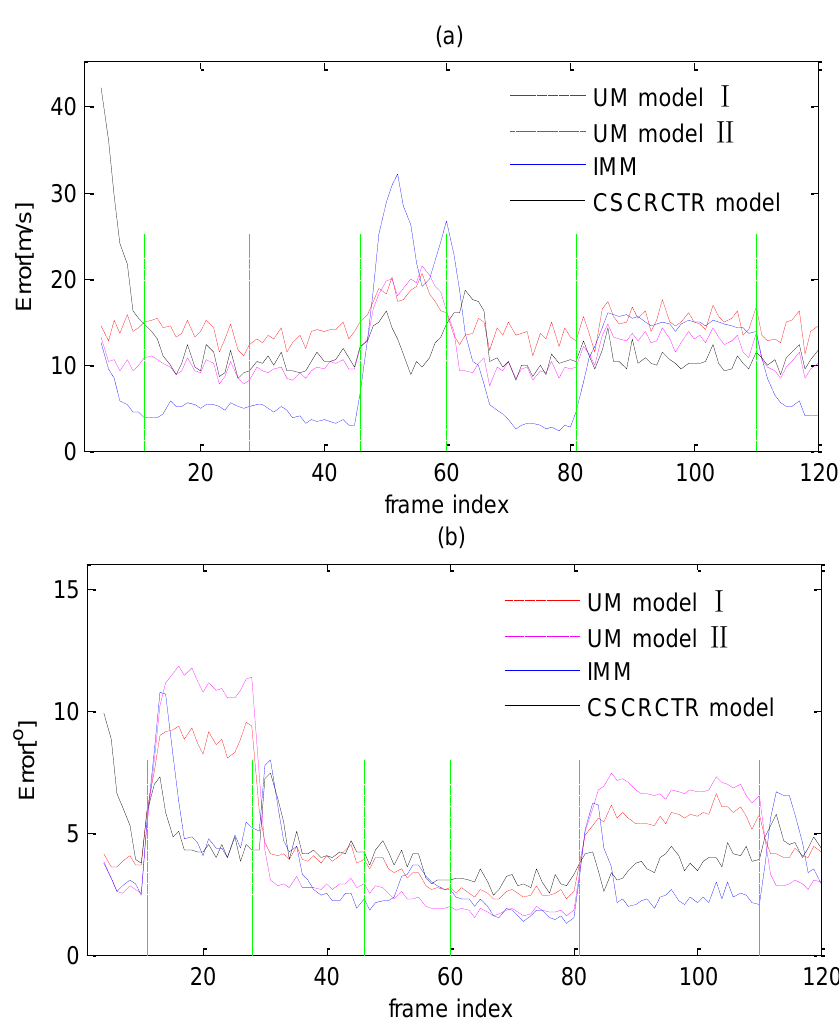
Figure 5. ( a ) RMS speed errors; ( b ) RMS heading angle